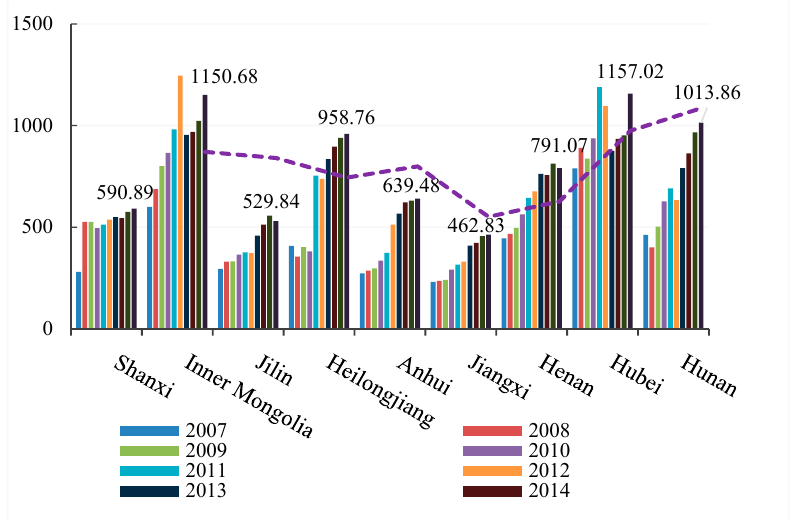
Figure 3. Transportation carbon emissions in the central region (2007–2016).